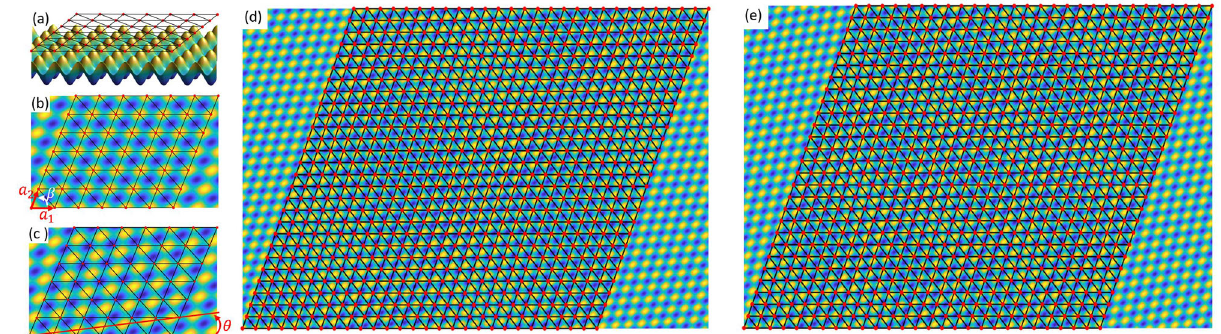
Fig. 1 Mechanical systems de fi ned. a Mechanical lattice (top layer) with an underlying potential surface (bottom layer). b Top view displaying lattice vectors a 1 and a 2 separated by an angle β . In this un-twisted con fi guration, the lattice sites are aligned with the peaks of the potential. c Also in a top view, the potential is twisted by an angle θ relative to the lattice. d , e Examples of truly aperiodic twisted bilayers for θ = π /50 and θ = π /25, respectively. The fi gures were generated for a 2 ¼